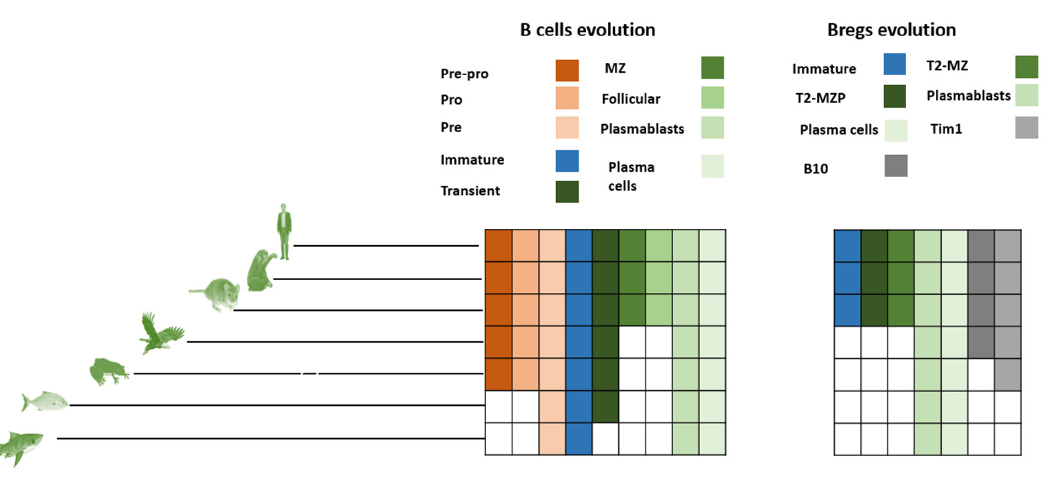
Figure 3. B cell evolution versus Breg evolution. Pre ‐ B cells, immature B cells as well as plasma cells and plasmablasts have been found in lower vertebrates. However, fish and sharks lack the regions needed for the existence of follicular B cells. Our phylogenetic investigation demonstrates that only plasmablasts, Bregs, and plasmablast B cells exist in fish (bony fish and cartilaginous fish).